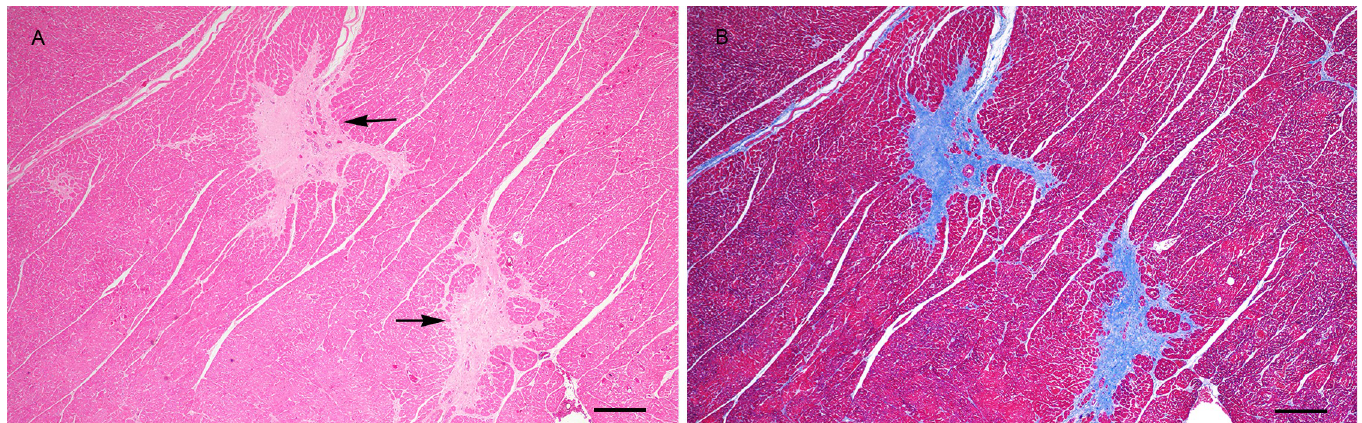
Fig 6. Photomicrograph of the heart from a bottlenose dolphin that stranded in 2012 in Alabama with severe fibrosis. A. Hematoxylin and eosin stained section of left ventricle. Note the pale staining fibrous connective tissue replacing and surrounding myocytes (arrows). B. Masson’s trichrome stained section of the same region of the left ventricle with severe fibrosis. Bar = 200 μ